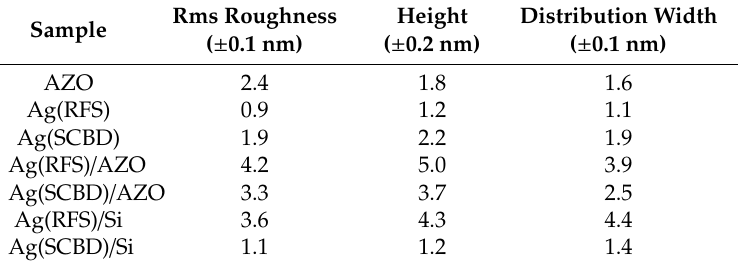
Figure 2. (1 × 1) µ m 2 AFM images of films deposited on PLA: ( a ) AZO; ( b ) Ag(RFS); ( c ) Ag(SCDB); ( d ) Ag(RFS) / AZO; ( e ) Ag(SCBD) / AZO. Scale bar for all panels is 200 nm. Images in panels ( a , d , e ) have been subtracted a polynomial background to remove the roughness of the AZO / PLA layer. Table 1. Rms roughness, height (mode of the distribution), and width (standard deviation) of height distributions obtained from the AFM analyses for coatings deposited on PLA and for reference Ag samples deposited on silicon.